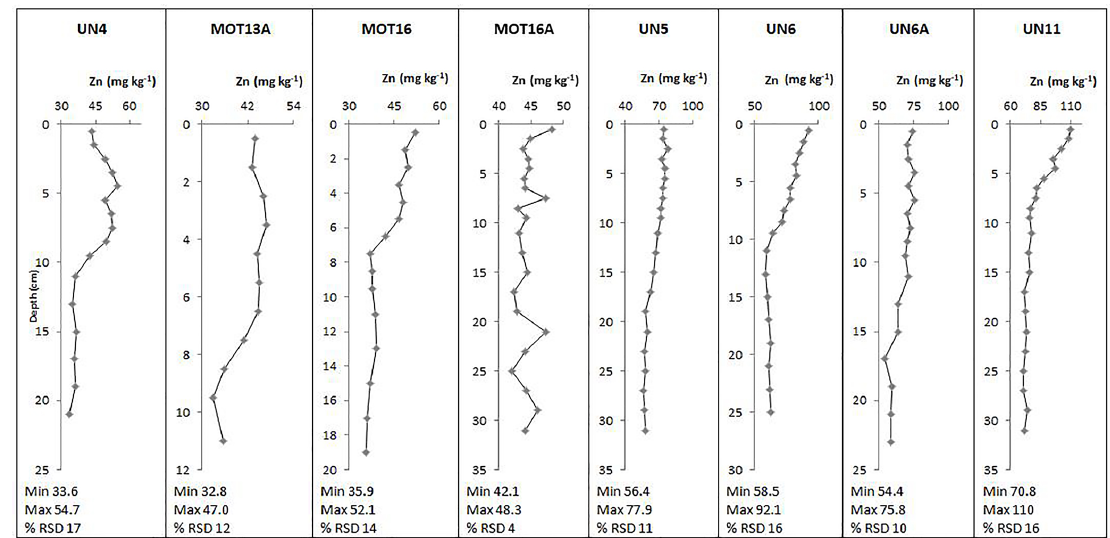
Figure A14. Vertical distributions of Zn (in mgkg − 1 ) in sediment cores. The concentrations in the coarse cores MOT13A, MOT16 and UN4 refer to the total sediment fraction ( <